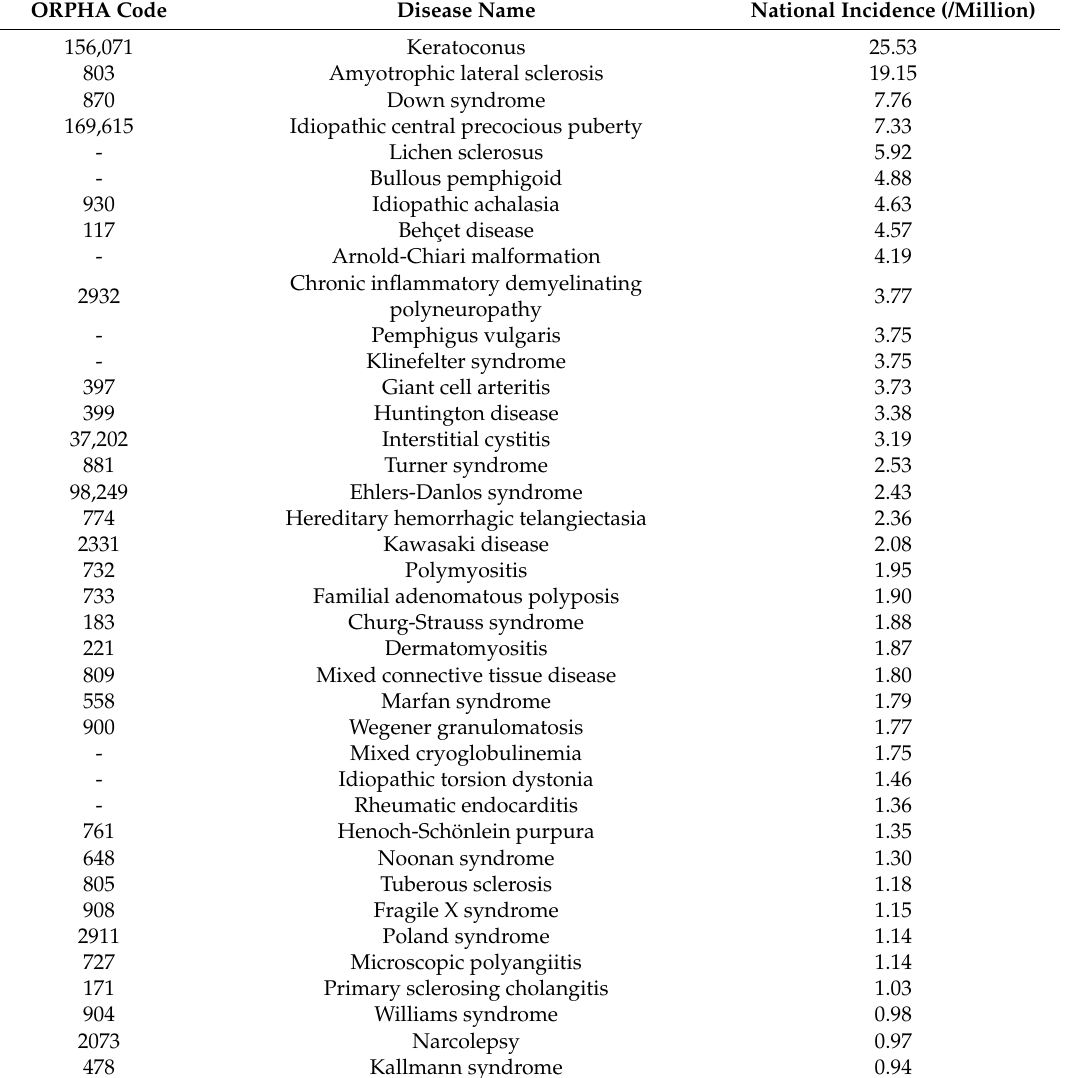
Table 3. National Incidence rates of most incident rare diseases and rare disease groups monitored by RNMR in the Italian population. Yearly average in the three-year period